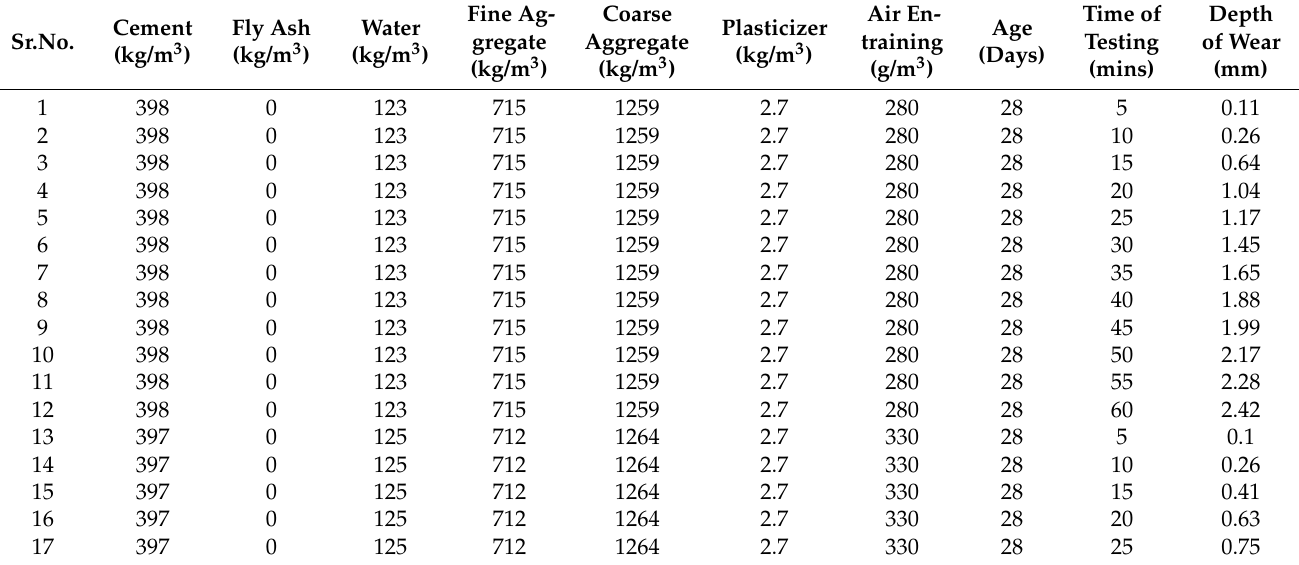
Table A1. Database of experimental